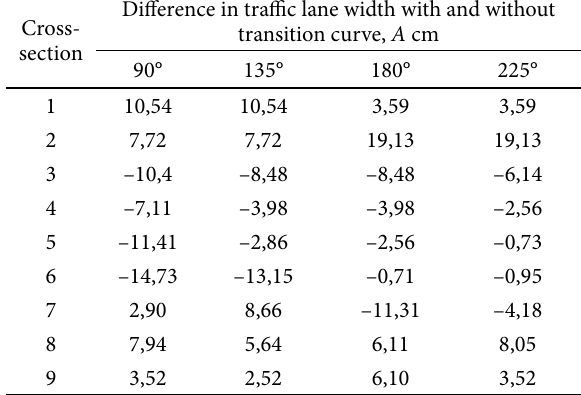
Table 2. Difference in traffic lane width with and without transition curve for curve radii R = 25 m Cross-